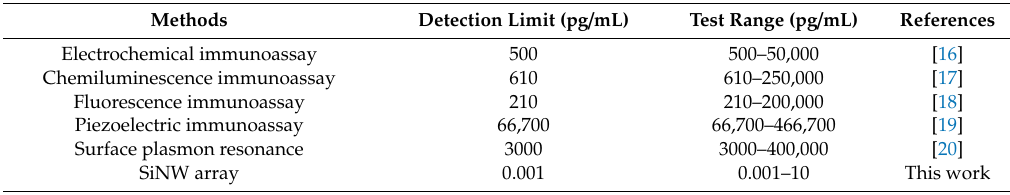
Table 1. Comparison of detection limit and test